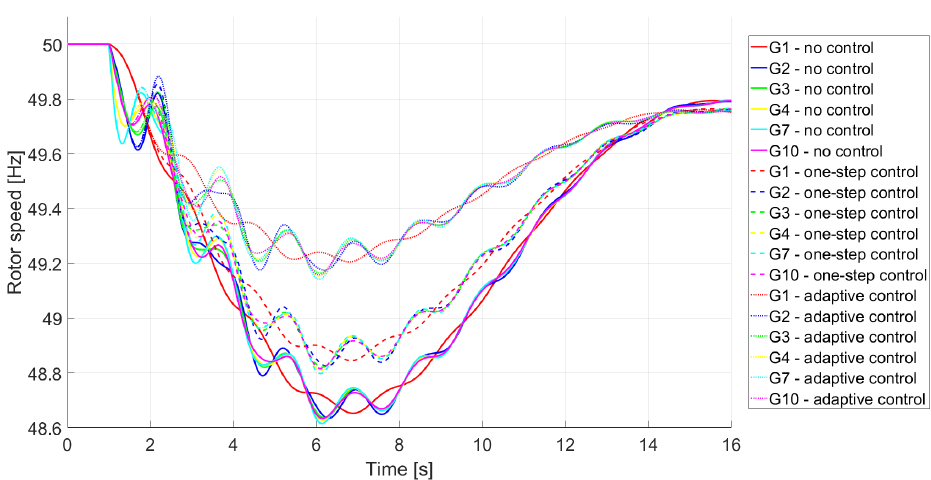
Figure 12. Frequency at bus 39 in Configuration II in case of big disturbance.